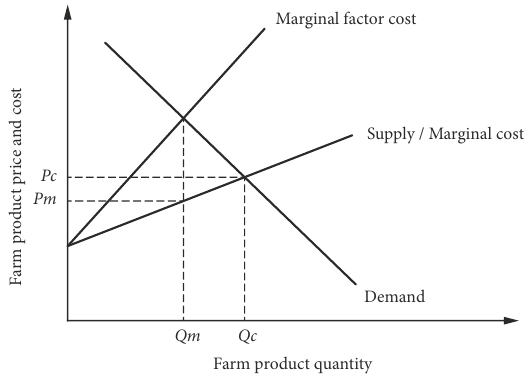
Figure 1. Monopsony price ( Pm ) at farm level vs competitive price ( Pc ) (source: own elaboration on the basis of Freebairn 2017)